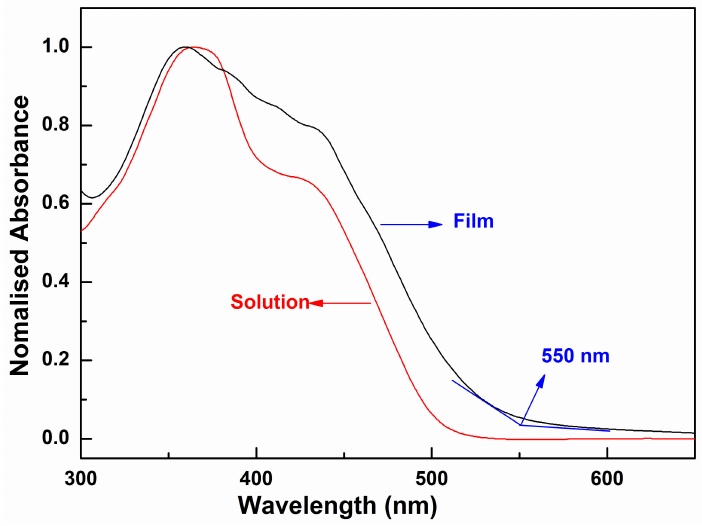
Figure 4. UV-vis absorption spectra of oligomer BDT(DBTOTTH) 2